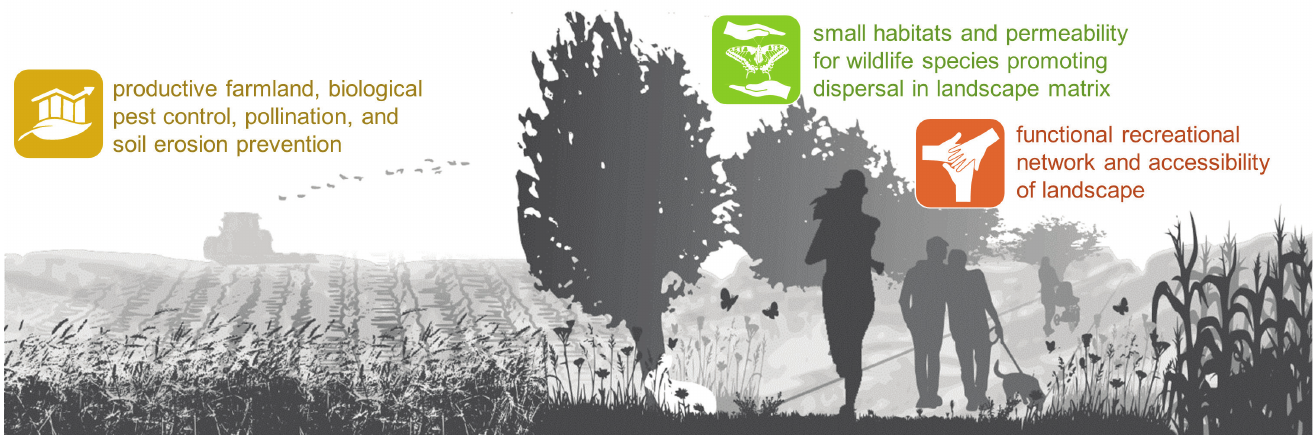
Figure 5. Illustration of multifunctional farmland corridors with potential key functions and benefits addressing urban